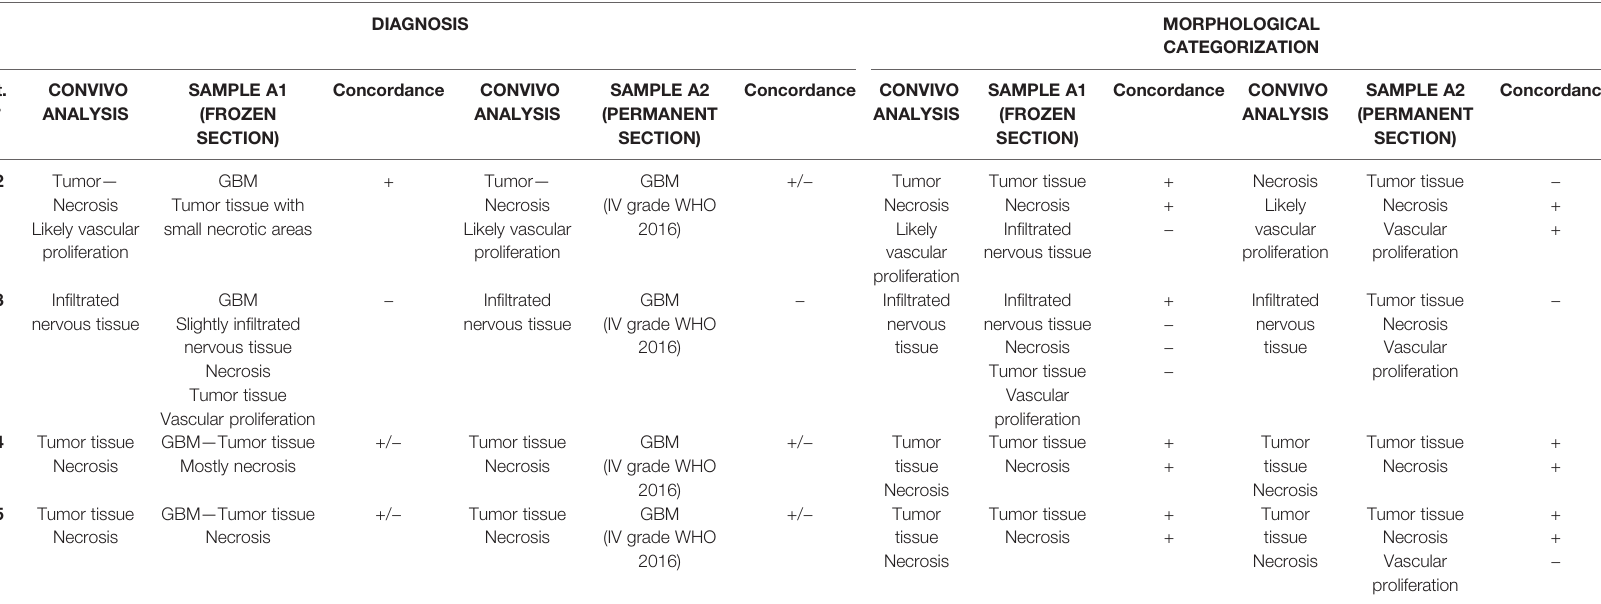
TABLE 2 | Comparison between CONVIVO ® , frozen section, and permanent section at the tumor